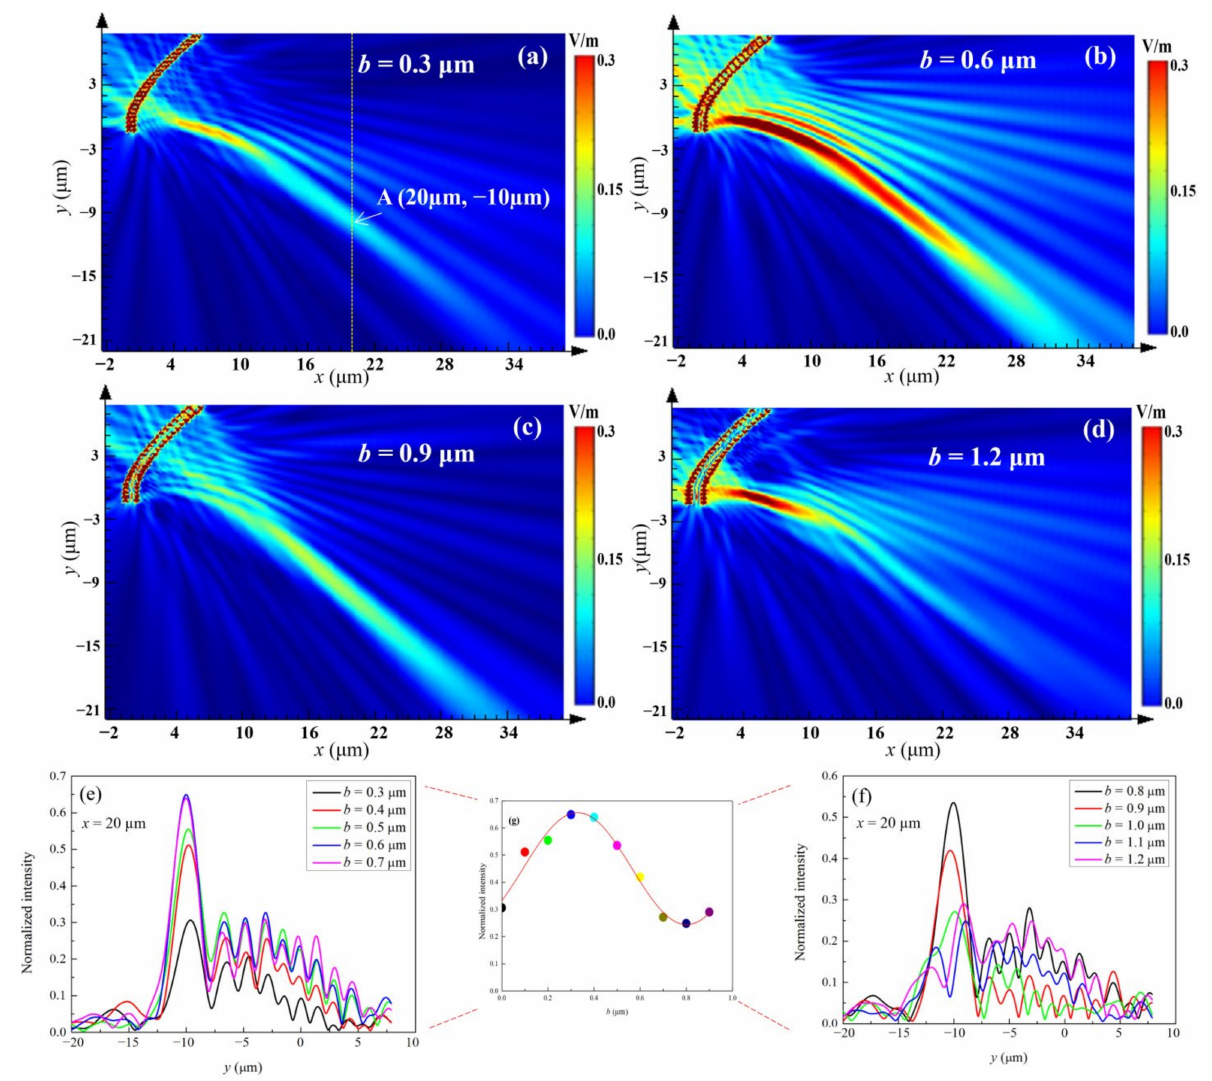
Figure 4. ( a – d ) Electric field intensity distribution for b = 0.3, 0.6, 0.9 and 1.2 µ m, respectively. ( e , f ) Transverse electric field intensity distribution at x = 20 µ m for different widths of b . ( g ) Fitting diagram for electric field intensities at point A with varied widths of b